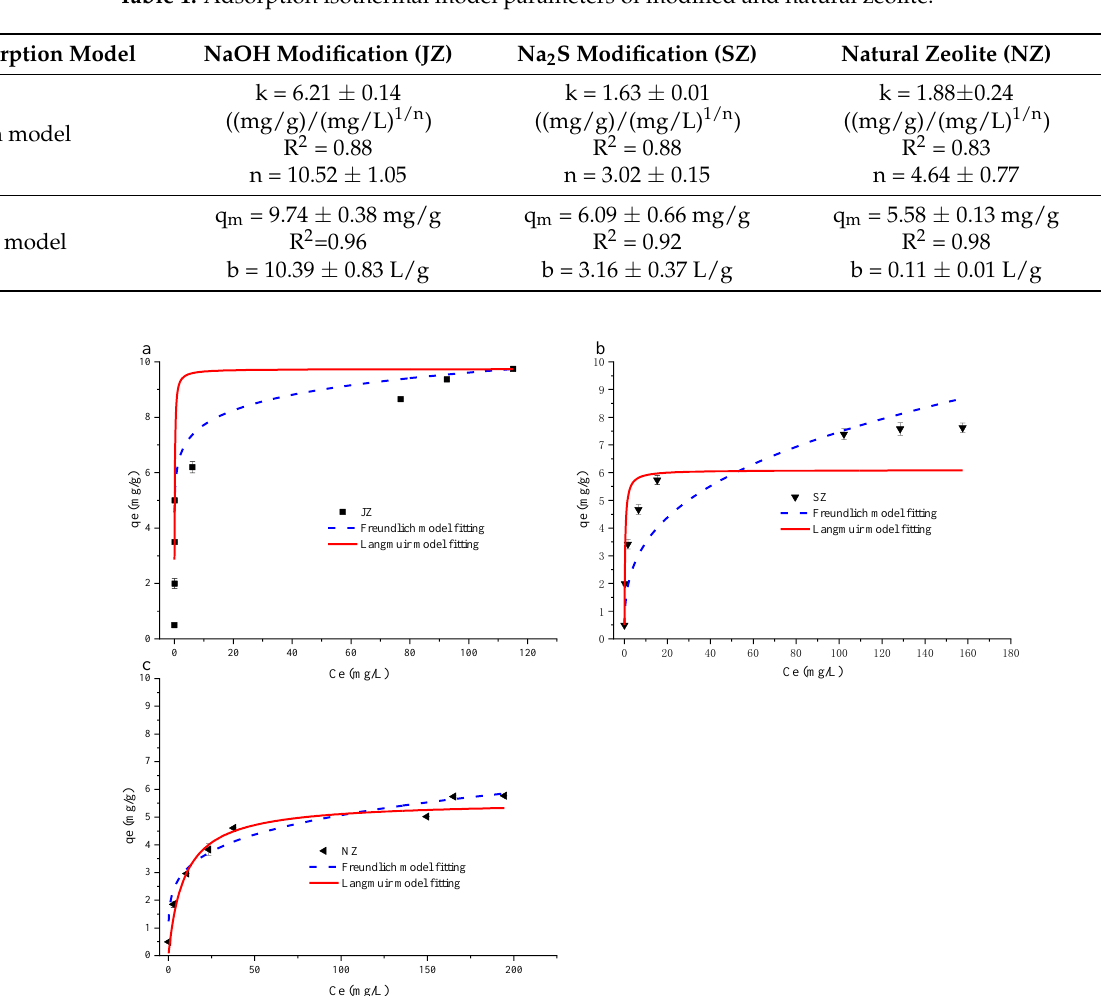
Figure 4. Curve presenting zeolite adsorption at different concentrations of Cd solution. Table 1. Adsorption isothermal model parameters of modified and natural zeolite.